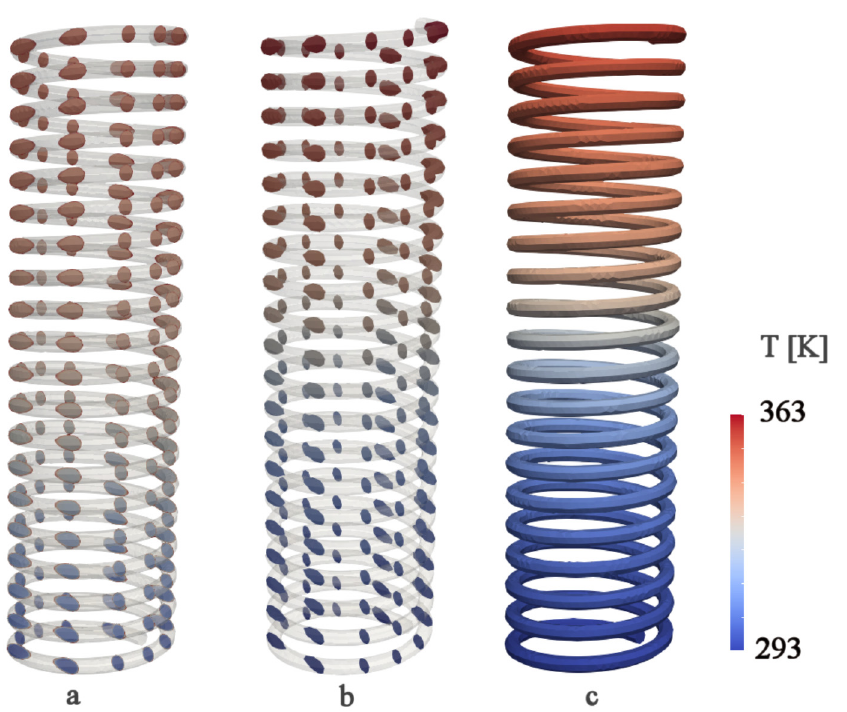
Figure 5. Temperature distribution of the load in steady state conditions: ( a ) slice plot, conventional heating; ( b ) slice plot, microwave heating, ( c ) surface plot, microwave heating.